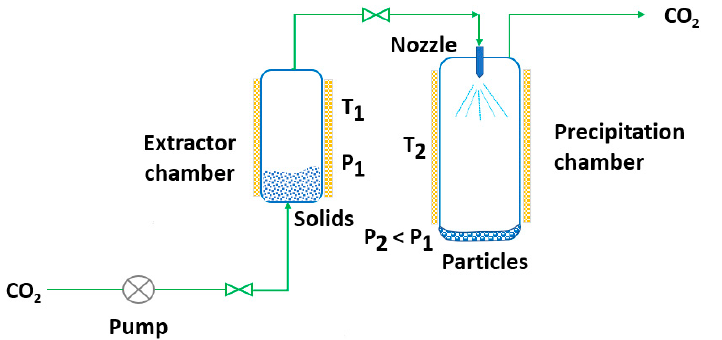
Figure 3. The rapid expansion of supercritical solvent (RESS) process (adapted from Parhi and Suresh [145]).